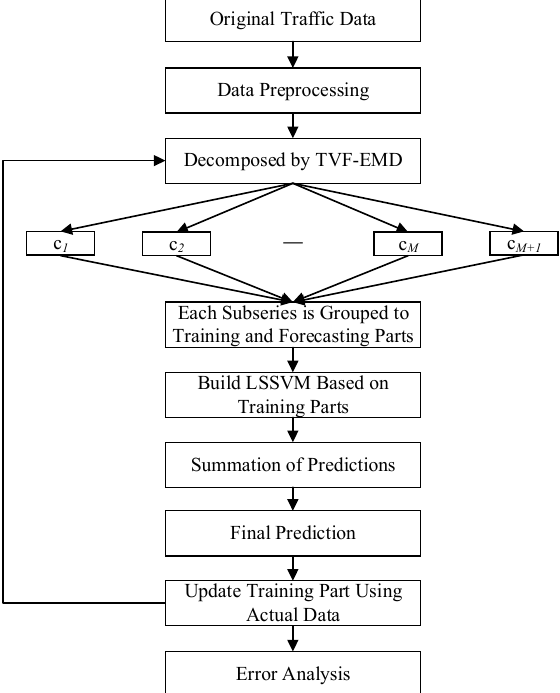
Figure 1. The procedure of time varying filtering based empirical mode decomposition and least square support vector machine